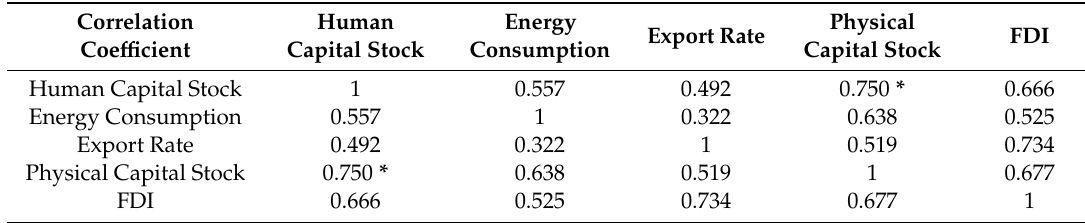
Table 1. Correlation coe ffi cients of evaluation variables.